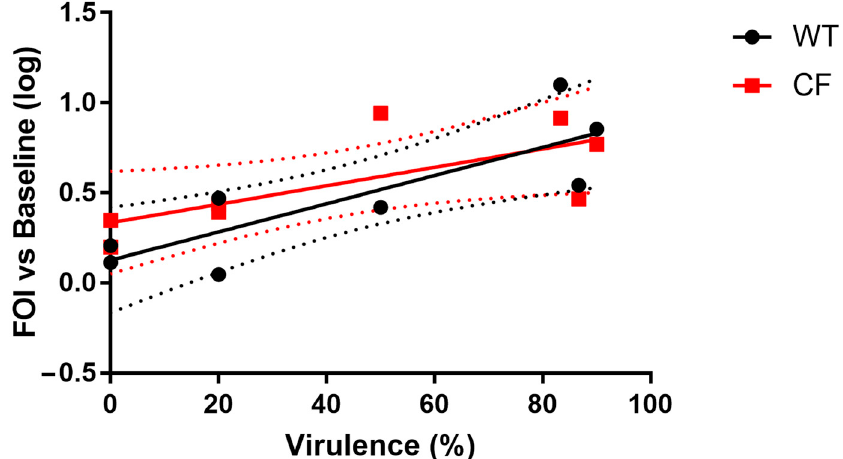
Figure 7. Correlation between IL-8-dependent bioluminescence emission in WT and KO mice at 24 h after intratracheal challenge with the clinical isolates and virulence in G. mellonella larvae infected with the same isolates. FOI = Fold of Induction vs. baseline (before lung challenge). Each point represents the mean ± SEM of four mice challenged with each isolate. Linear regression ± SEM (dotted lines) is shown.